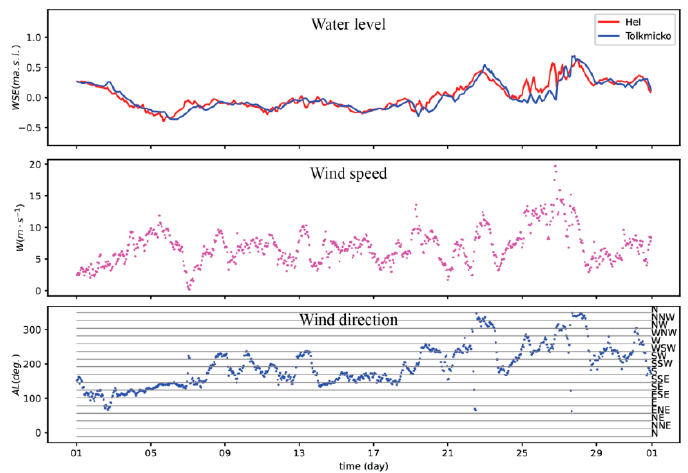
Figure 3. Water level (WSE) variation at Hel and Tolkmicko stations and wind speed and direction observed at Nowa Pas łę ka in January of 2008 (raw data; measurement frequency of WSE is 10 (min), wind data 1 (h)).